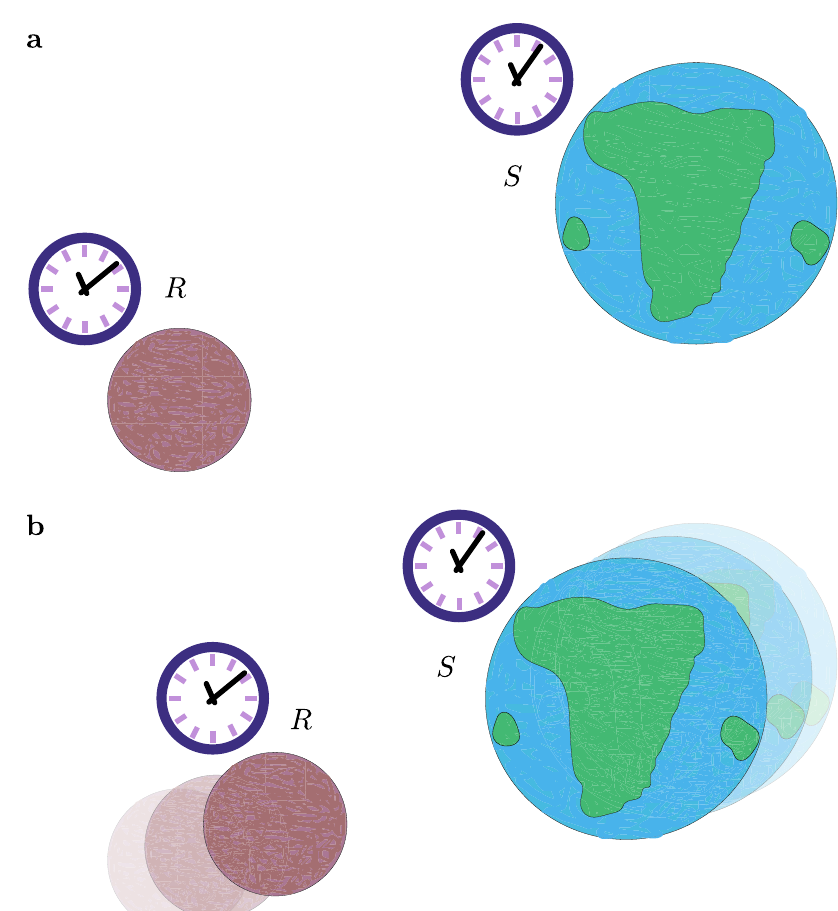
Fig. 2 Representation of gravitational interaction between two massive systems. Systems R and S have each their own internal quantum time. As shown in a , if the relative spatial distance between the systems is kept constant, the time evolution from the perspective of either of their clocks is unitary, even though the gravitational interaction causes a type of time dilation in the clocks. However, as illustrated in b , if the relative spatial distance between the systems changes due to the gravitational attraction, the description of their time evolution given by either of their clocks is generally non-unitary. This is the case even if one of the systems is assumed to be much more massive than the other and, therefore, can be approximated as